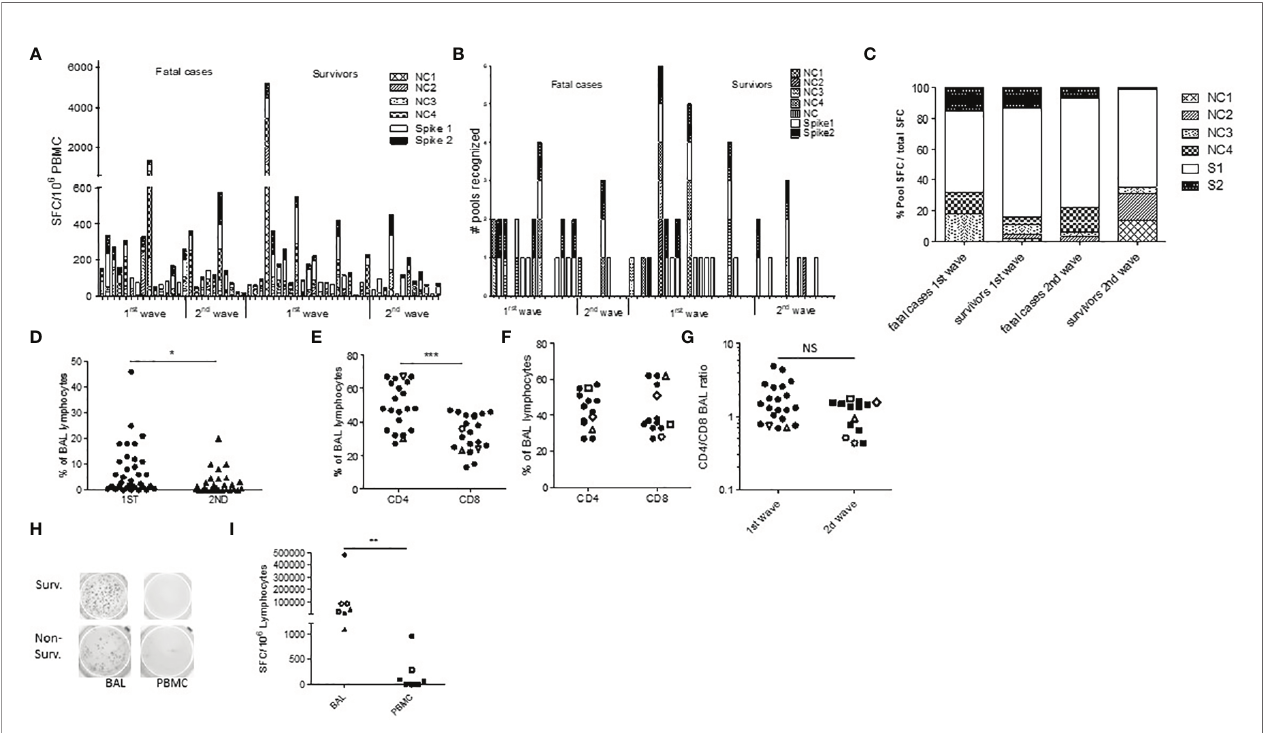
FIGURE 2 | SARS-CoV-2-speci fi c T cells traf fi cking to the lungs in severe COVID-19 infection. (A, B) PBMC ELISpot IFN- g assays against spike protein (S, 2 peptide pools) and nucleocapsid (NC, 4 peptide pools) were assessed in 36 fi rst-wave ICU patients at fi rst time point and in 24 second-wave ICU patients (A, B) . Results are expressed as SFC units (A) or as a number of recognized peptide pools (B) . (C) Percentage of the total SFC response against SARS-CoV-2 peptide pool in each group. (D) Proportion of lymphocyte (Ly) on fi rst BAL elements in fi rst-wave patients (round symbols) and second-wave patients (triangles). (E, F) %CD3 +CD4+ and CD3+CD8+ T cell in BAL lymphocytes in all BAL samples from fi rst wave (E) and second wave (F) , and comparison of the CD4/CD8 BAL ratio during the fi rst and second waves (G) . Open symbols are deceased patients. (H, I) Comparison of BAL lymphocytes and PBMC SARS-CoV-2 ELISpot IFN- g assays in two representative patients (H) and in all patients (I) . *p<0.05 ***p<0.001; NS, not signi fi